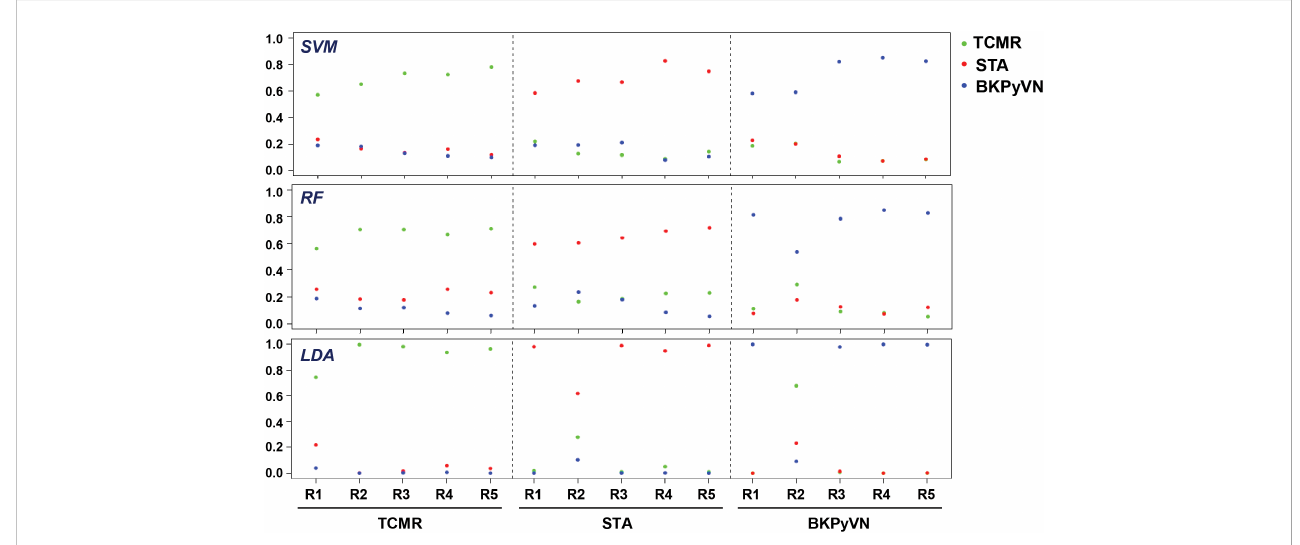
FIGURE 4 Diagnostic ability of the three different predictive models applied to disease and normal phenotypes. The probability calculated for the kidney transplant biopsy specimens using biomarker panel with the three different prediction models. LDA directly provides posterior probabilities. For random forest (RF), the probabilities are the proportions of votes among the ensembled trees. For SVM, we fi t logistic distribution and obtain posterior probabilities by setting probabilities=TRUE in svm function of “ e1071 ” package. R1-R5 are individual samples in each kidney